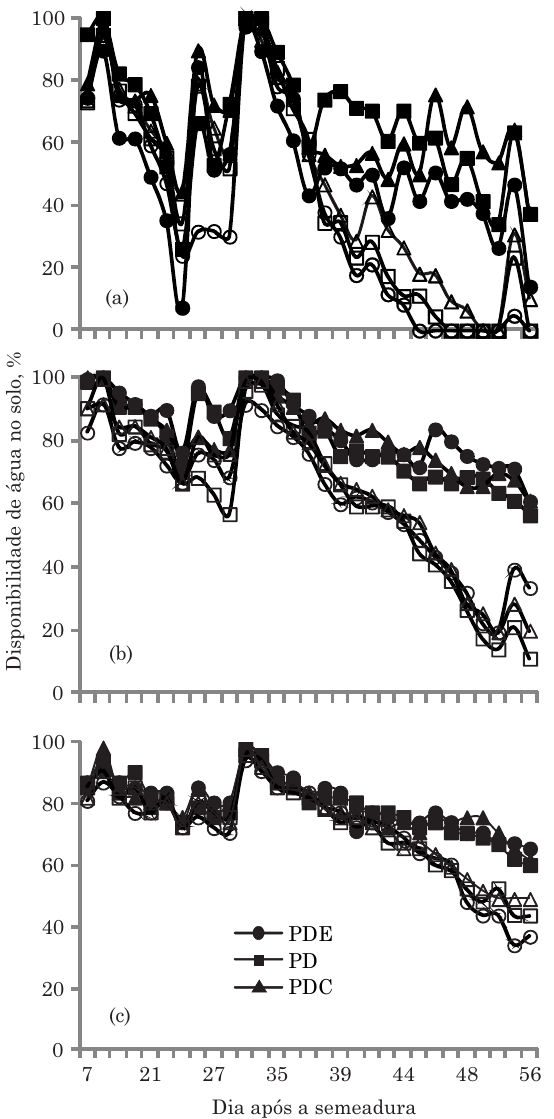
Figura 2. Disponibilidade de água no solo, no período de sete a 56 dias após a semeadura, em diferentes níveis de compactação, com irrigação (símbolos preenchidos) e sem irrigação (símbolos vazios), nas camadas de 0-0,10 m (a), 0,15-0,25 m (b) e 0,30-0,45 m (c). PD: plantio direto; PDE: plantio direto escarificado; e PDC: plantio direto